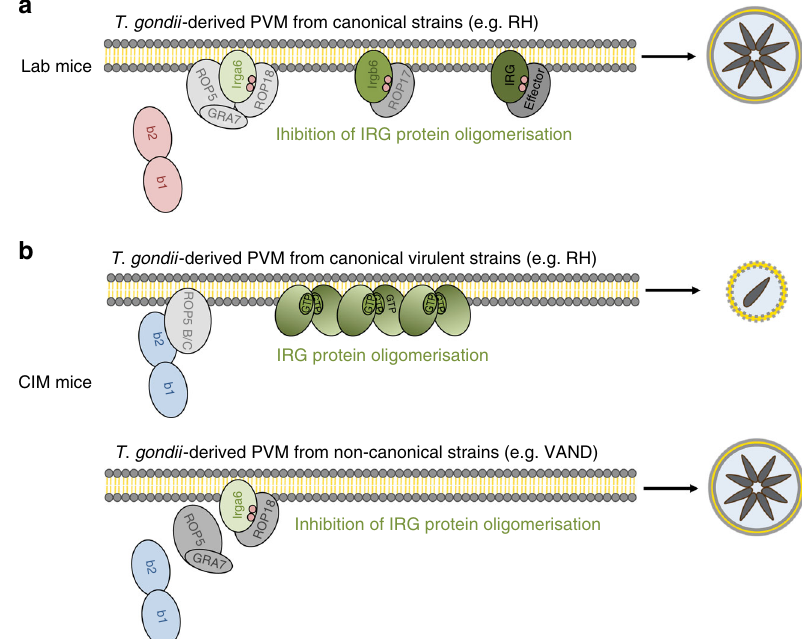
Fig. 7 Model for Irgb2-b1-mediated control of T. gondii infection in wild-derived mice. a In laboratory mice, effector proteins from canonical virulent T. gondii strains (like RH) speci fi cally phosphorylate certain Immunity-Related GTPases (IRG) proteins, thereby inhibiting oligomerisation and destruction of the parasitophorous vacuolar membrane (PVM). Two rhoptry kinases, ROP18 and ROP17, have been demonstrated to preferentially phosphorylate Irga6 BL/6 or Irgb6 BL/6 . The existence of additional parasite effectors speci fi c for other IRG proteins is assumed. b In CIM and probably other wild-derived mice, canonical virulent T. gondii strains (like RH) are counteracted by direct binding of ROP5 isoform B by the polymorphic tandem IRG protein Irgb2-b1 CIM . IRG effector proteins are free to accumulate around the PVM, resulting in growth control, encystment and transmission of the parasite. Genetically more diverse T. gondii strains, like T. gondii VAND from South America, express polymorphic ROP5 variants that are not targeted by Irgb2-b1 CIM . Consequently, effector IRG proteins such as Irga6 CIM are phosphorylated and inactivated by a T. gondii VAND kinase complex. Infected animals die shortly after parasite challenge. Molecular interaction between ROP18 and ROP5 or Irga6 and ROP5 within the VAND kinase complex awaits experimental con fi rmation